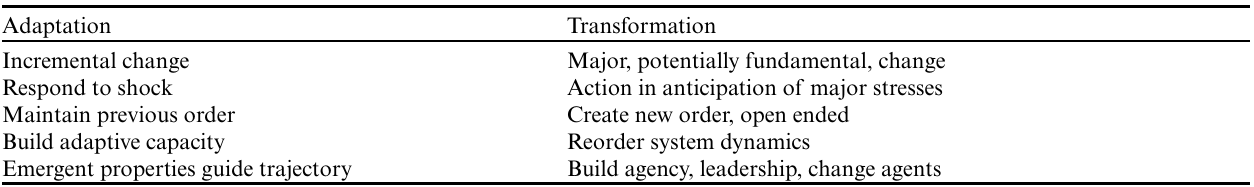
Table 1 . Contrasting elements of adaptation and